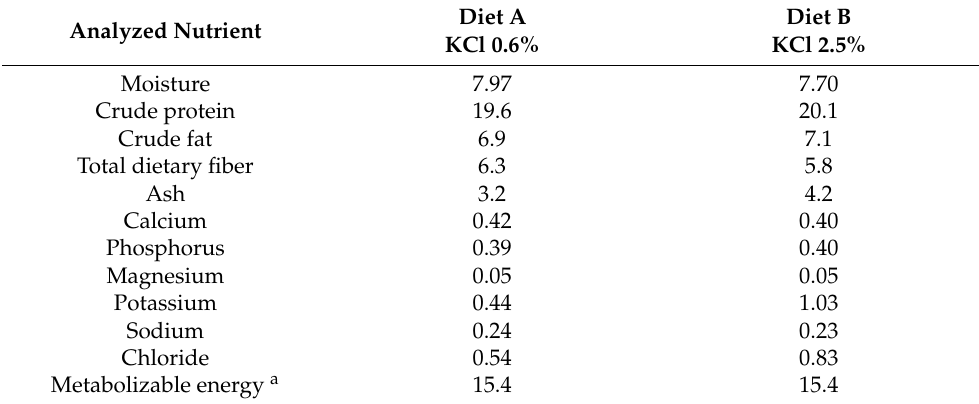
Table 1. Ingredient composition and analyzed nutrient profiles of the experimental diets. Analyzed